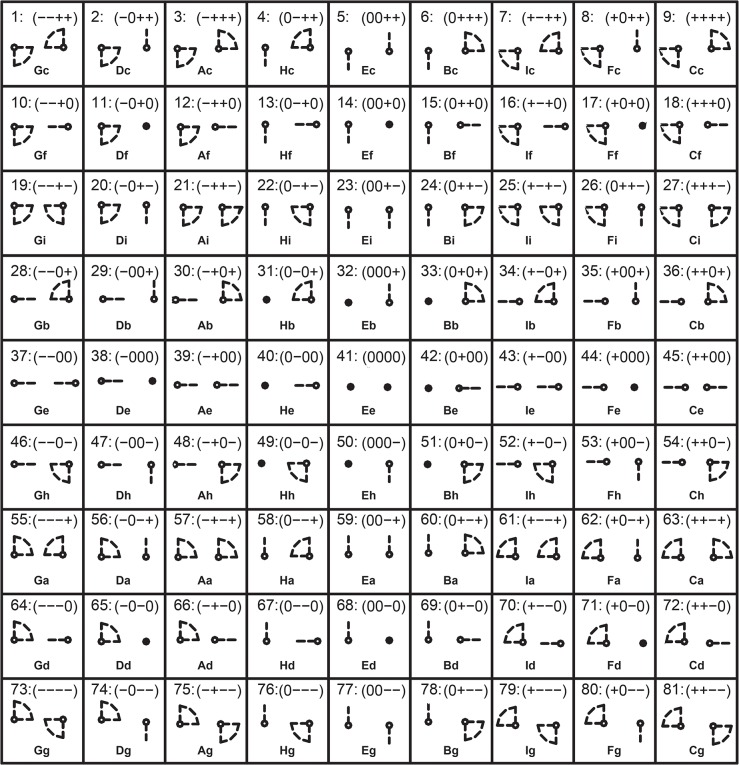
81 QTCC base relations.